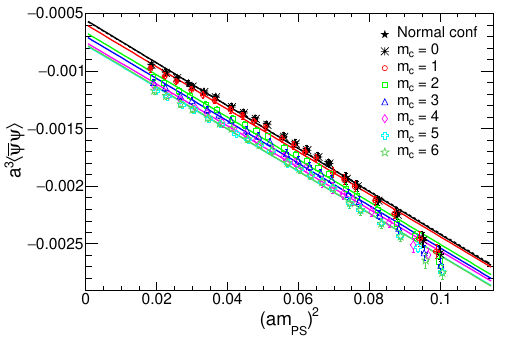
Figure 16 . Comparisons of the renormalized chiral condensate h (cid:22) i GMOR with the predic- MS tion h (cid:22) i Pre . The solid blue and black lines in- dicate the (cid:12)tting results of the numerical results and prediction,